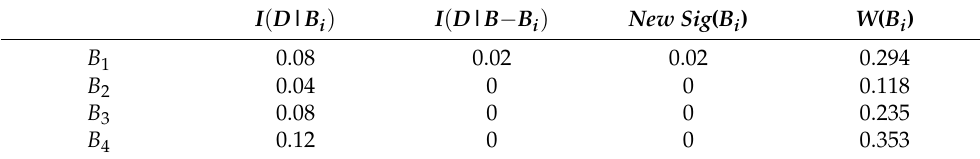
Table 4. Conditional entropy, importance degree and attribute weight of criterion layer.